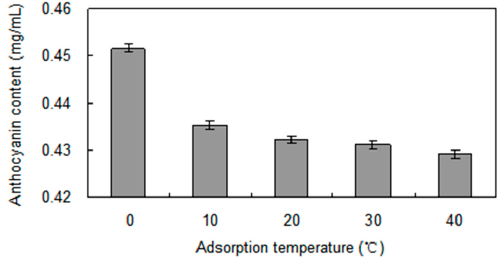
Figure 2. Effect of absorption temperature on S. chinensis anthocyanins content with HPD-300 resin.